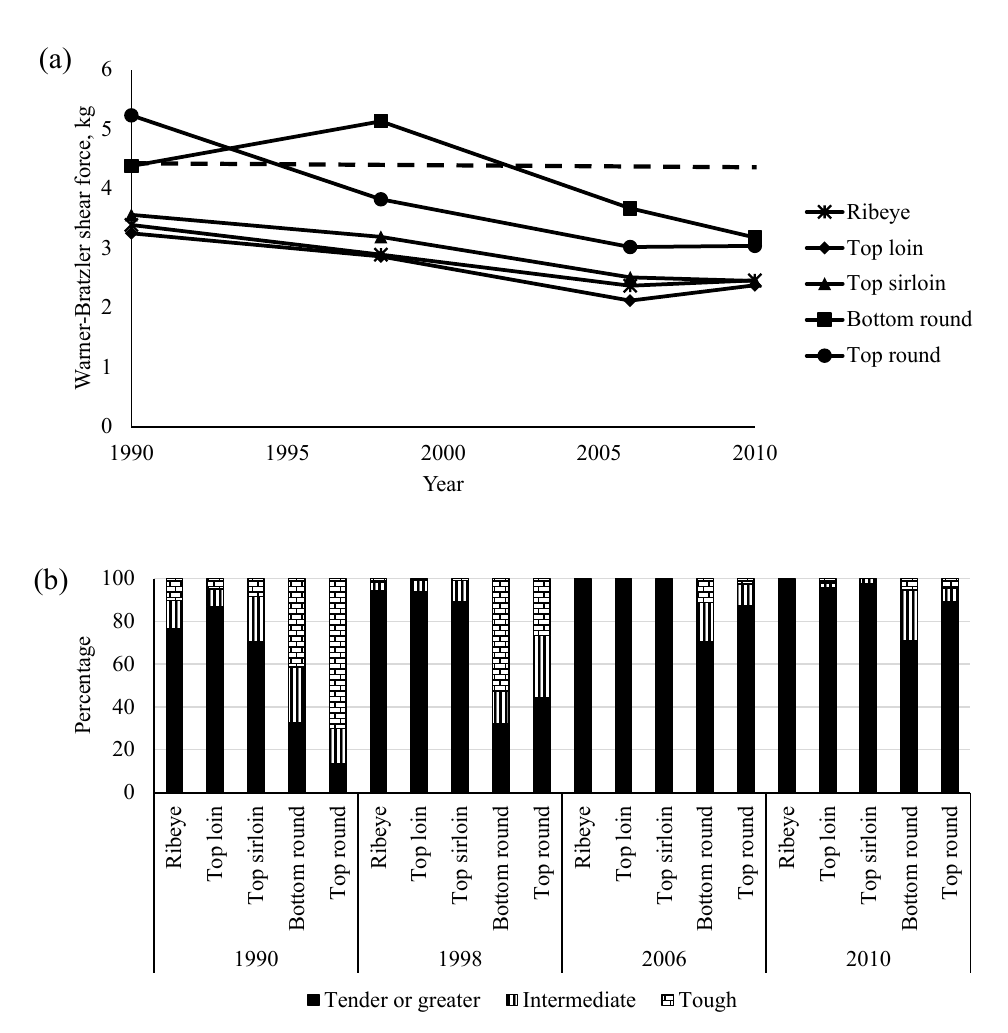
Figure 4. Rib, loin, and round objective tenderness values and categorization over the 20 years covered by the National Beef Tenderness Surveys. (a) Warner-Bratzler shear force (WBSF) values of steaks. Blue dashed line represents a WBSF value of 4.4 which is the threshold at which tested beef products can enter guaranteed tender beef programs [18] (b) Percentage of steaks grouped into tender or greater (WBSF≤3.9), intermediate (3.8 to 4.5), and tough (>4.5 kg) tenderness categories. Adapted from Morgan et al [15], Brooks et al [11], Voges et al [12], and Guelker et al [13].